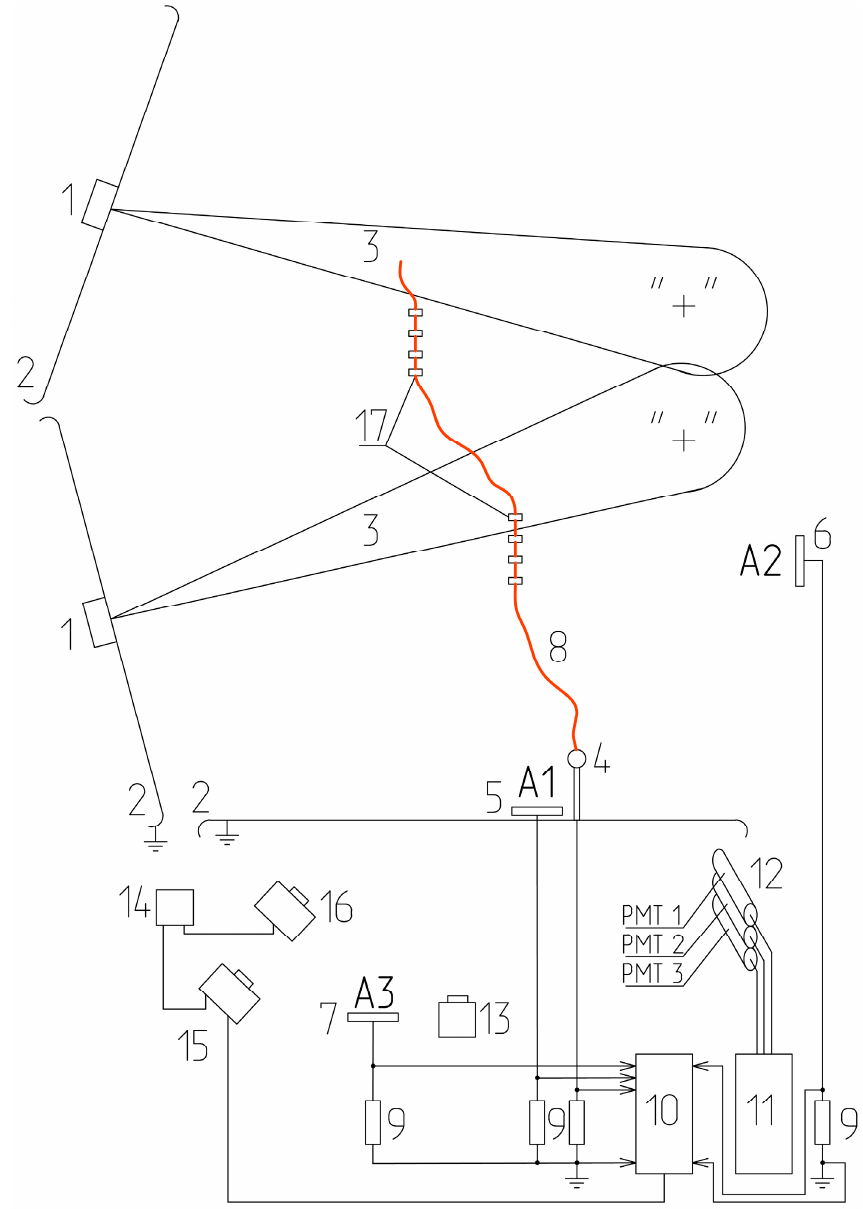
Figure 1. Basic scheme of the experimental measurement complex: 1—charged aerosol